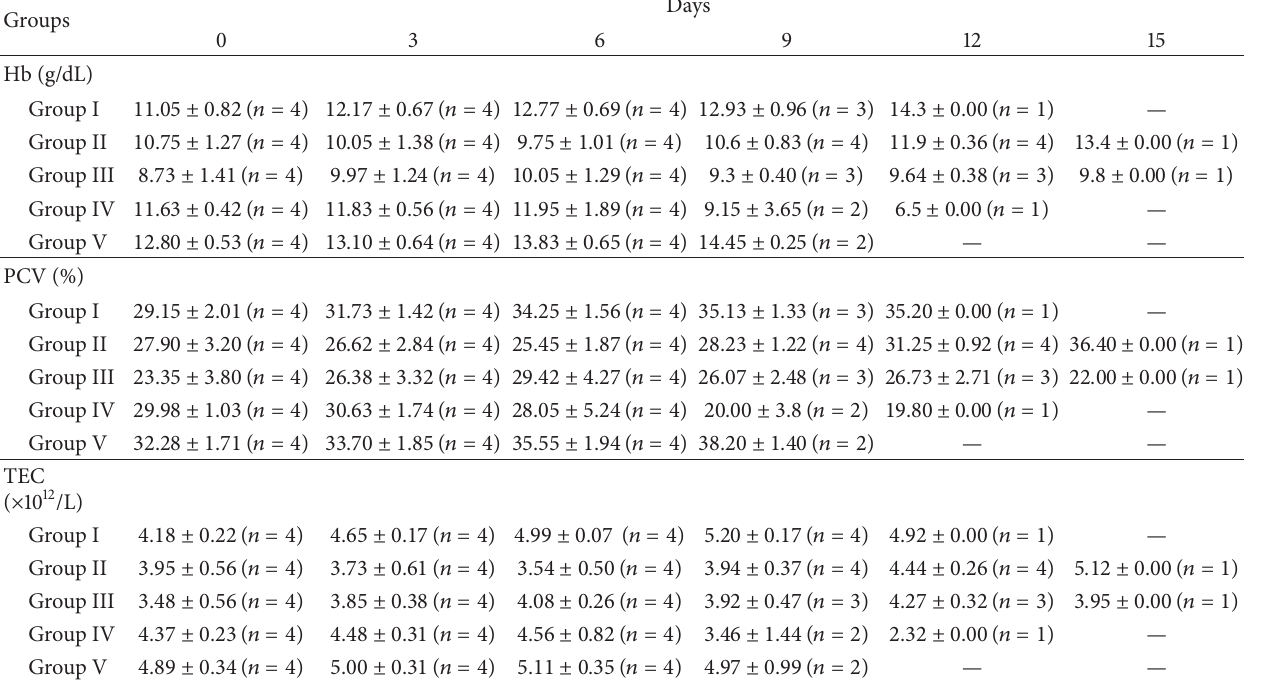
Table 5: Hemoglobin, packed cell volume, and total erythrocyte counts of different groups at various observation intervals (mean ± S.E.). Groups